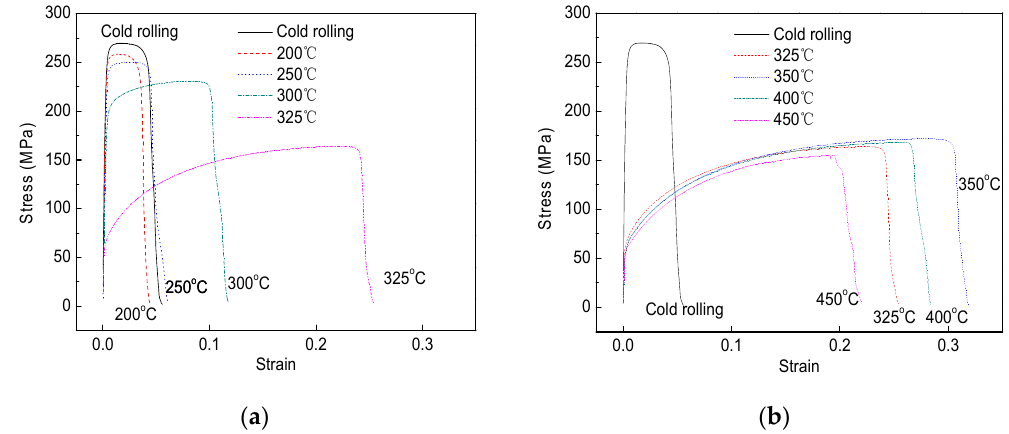
Figure 7. Stress-strain curves of the composites annealed at different temperatures: ( a ) 200–325 °C; ( b ) 325–450 °C.